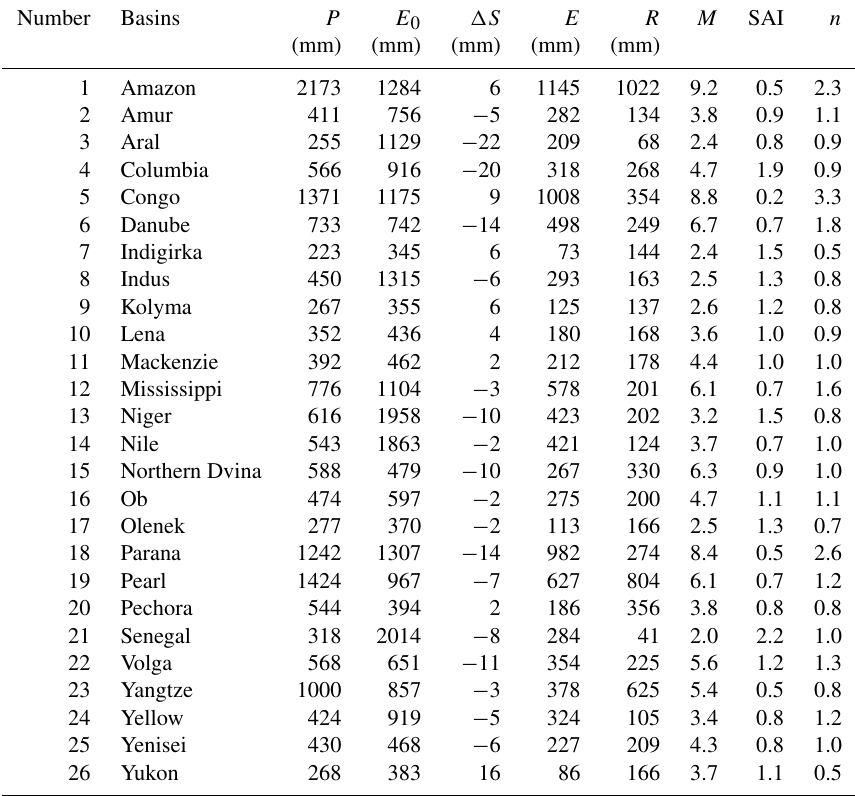
Table 1. Long-term annual mean meteorological and hydrological characteristics and vegetation coverage (1984-2006) for the 26 large river basins around the world.